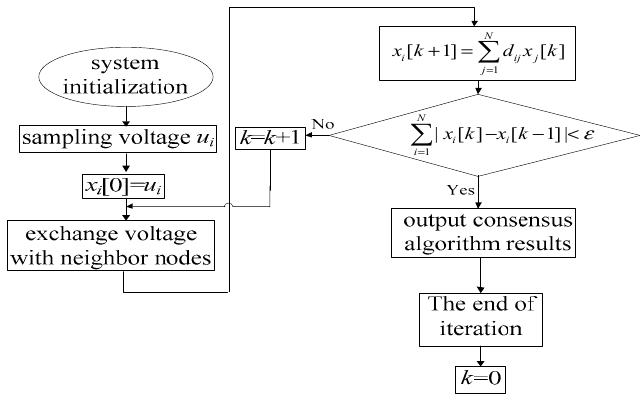
Figure 7. Flow chart of the discrete consensus algorithm.